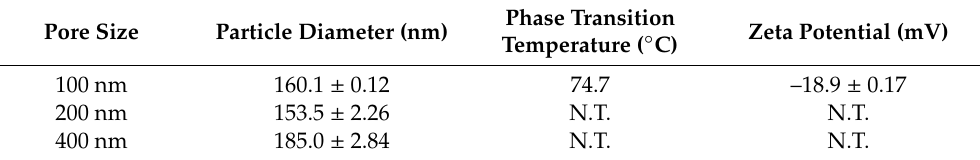
Figure 1. Characterization of mannosylerythritol lipid B (MEL-B) liposomes. ( a ) The change in particle diameter as measured by dynamic light scattering; ( b ) the thermotropic phase transitions as measured by di ff erential scanning calorimetry (DSC). Symbol: circle, 100 nm; square, 200 nm; and triangle, 400 nm. Table 1. The characteristics of MEL-B liposomes.